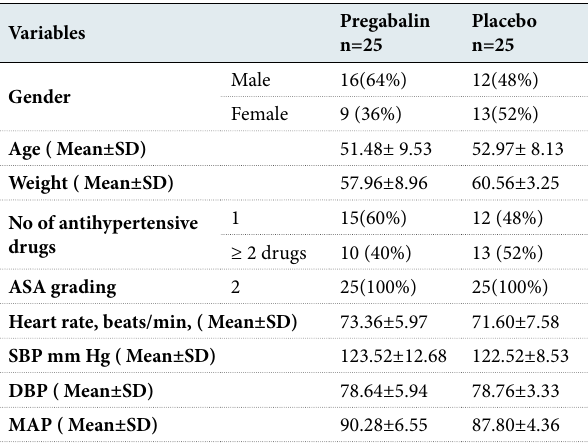
Table 1: Baseline characteristics of the study population